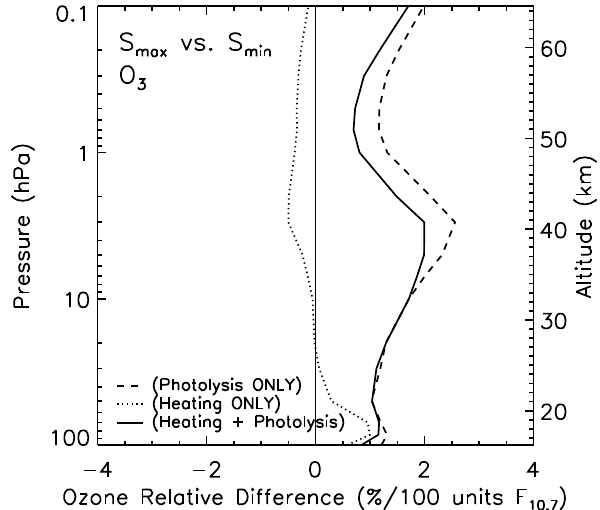
Fig. 2. Ozone response to the 11-yr solar cycle, S max − S min (rela- tive %) per 100 units of F 10 . 7 , in the stratosphere and lower meso- sphere and averaged over 60 ◦ S–60 ◦ N latitude, as modeled by the GEOSCCM using the NRL SSI. Three cases are shown, where the solar cycle has been applied (1) only to direct radiative heating, (2) only to photolysis, and (3) with both effects